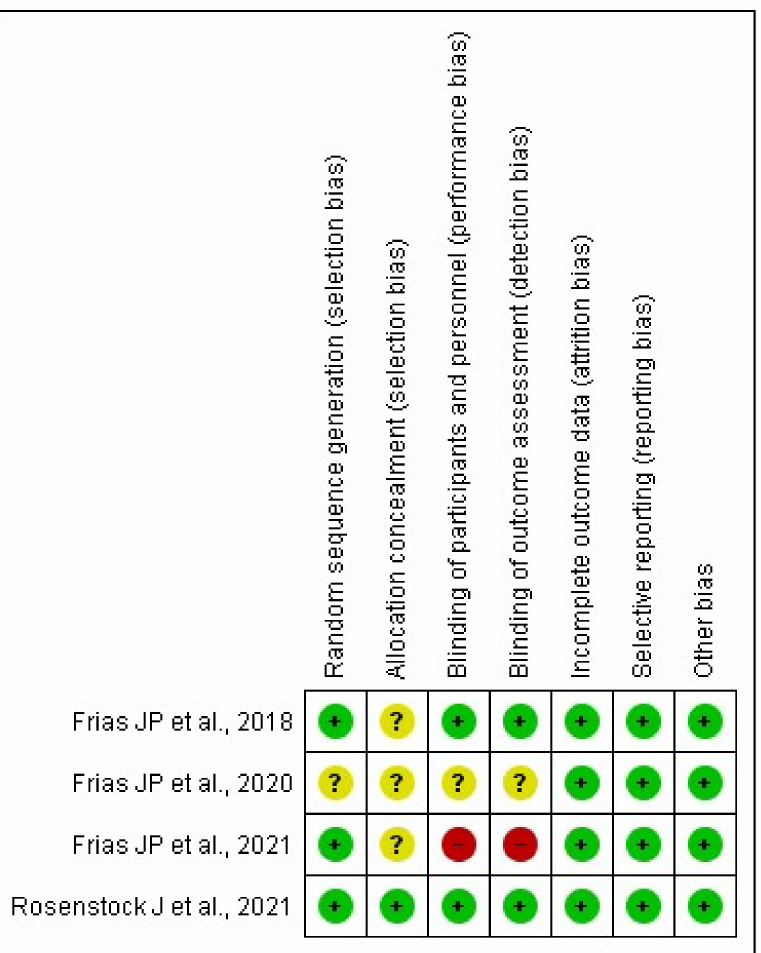
Figure 2. Assessment of the risk of bias in included studies with Cochrane domain-based quality assessment